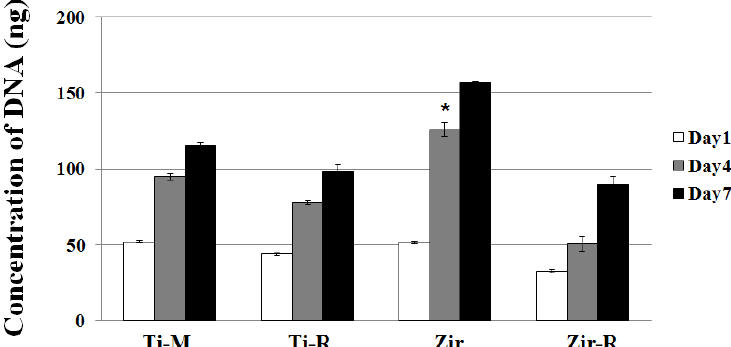
Figure 3. Cell proliferation assay (picogreen assay) of MC3T3-E1 cells at Day 1, 4 and 7 seeded on Ti- or Zr-discs. Data are expressed as the mean ±standard deviation (SD) of (ANOVA) test ( * p < 0.05).